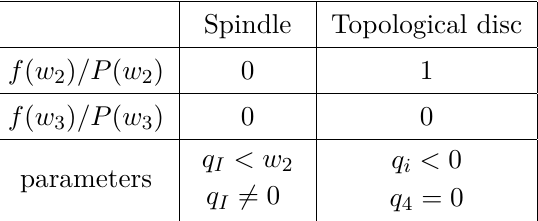
Table 2 . Summary of the main properties that distinguish the spindle and topological disc solu- tions. The ratio f ( w ) /P ( w ) indicates whether the circle S 1 degenerates or remains of finite size z at the endpoints of the domain [ w 2 , w 3 ] . Schematic graphs of the functions f ( w ) and P ( w ) for the two respective classes of solutions have also been included in figures 1 and 2.